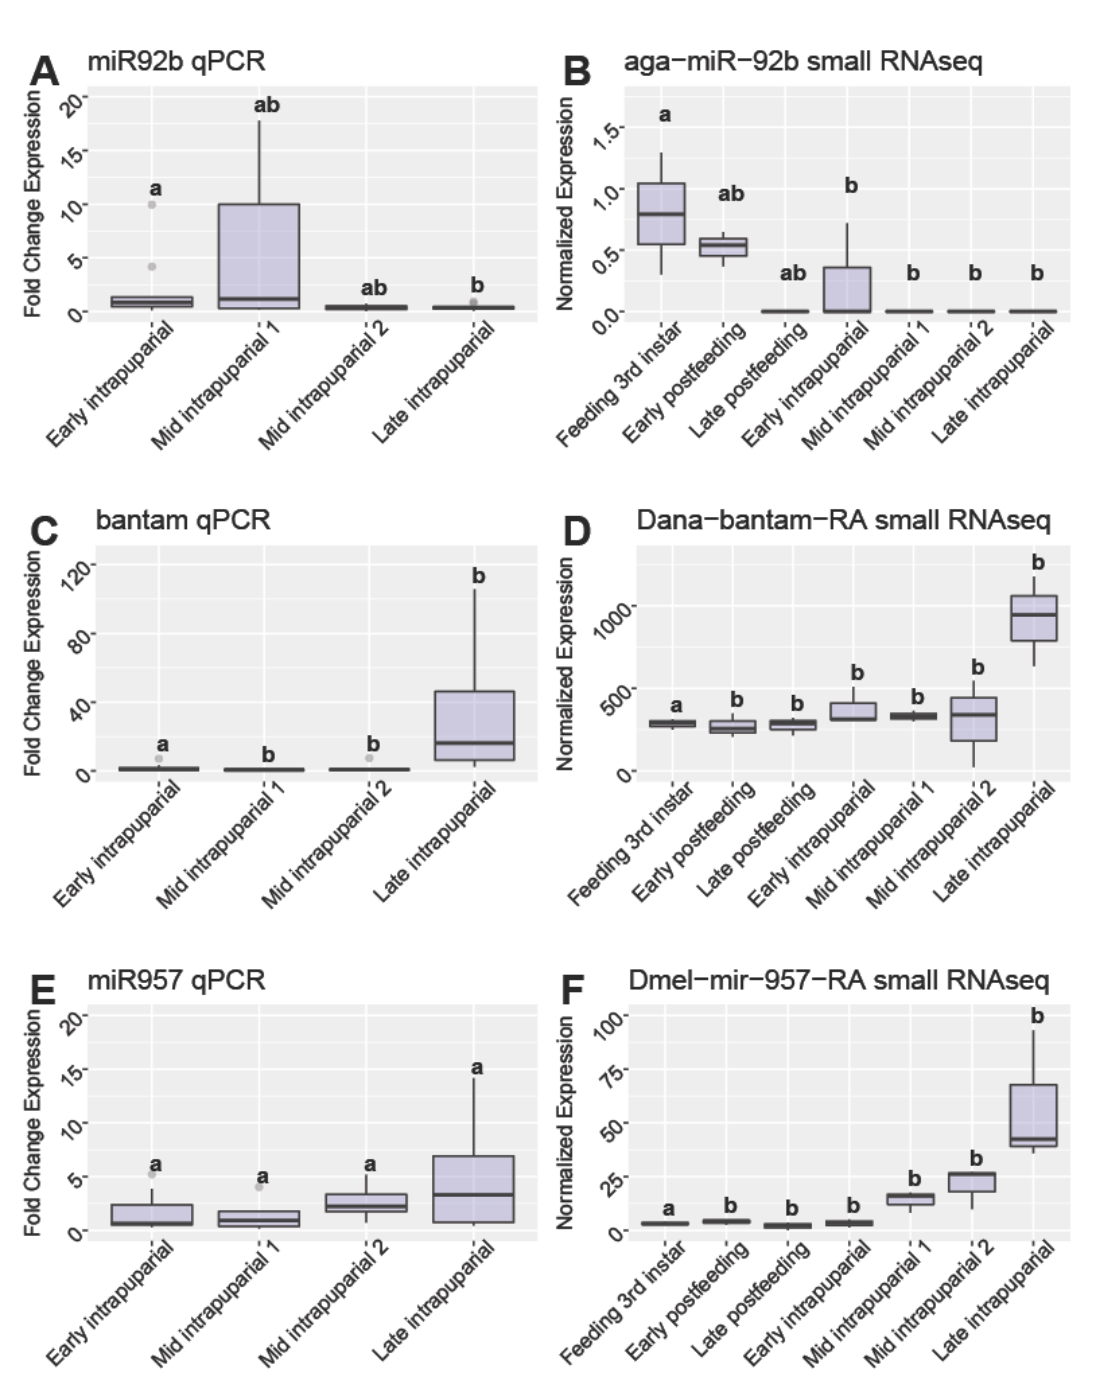
Figure 5. Comparison of expression qPCR and RNAseq. Expression of qPCR (fold-change expression, left) and RNAseq methods (normalized expression) (right) Letters correspond to results of Tukey’s HSD posthoc test. Different letters between groups within plots indicate significant differences ( p < 0.05). Shared letters indicate no significant difference between groups. ( A ) miR-92b qPCR and ( B ) miR-92b RNAseq methods. Expression in qPCR samples was found to be significantly higher in mid-intrapuparial 1 than in late intrapuparial samples according to Tukey’s HSD ( p < 0.05). ( C ) bantam qPCR and ( D ) bantam RNAseq methods. Expression in qPCR samples was found to be significantly higher in the late intrapuparial development point than the early intrapuparial samples according to Tukey’s HSD ( p < 0.05). ( E ) miR-957 qPCR and ( F ) miR-957 RNAseq methods. Expression was not found to differ significantly between development time points in qPCR samples for miR-957 , according to Tukey’s HSD ( p <